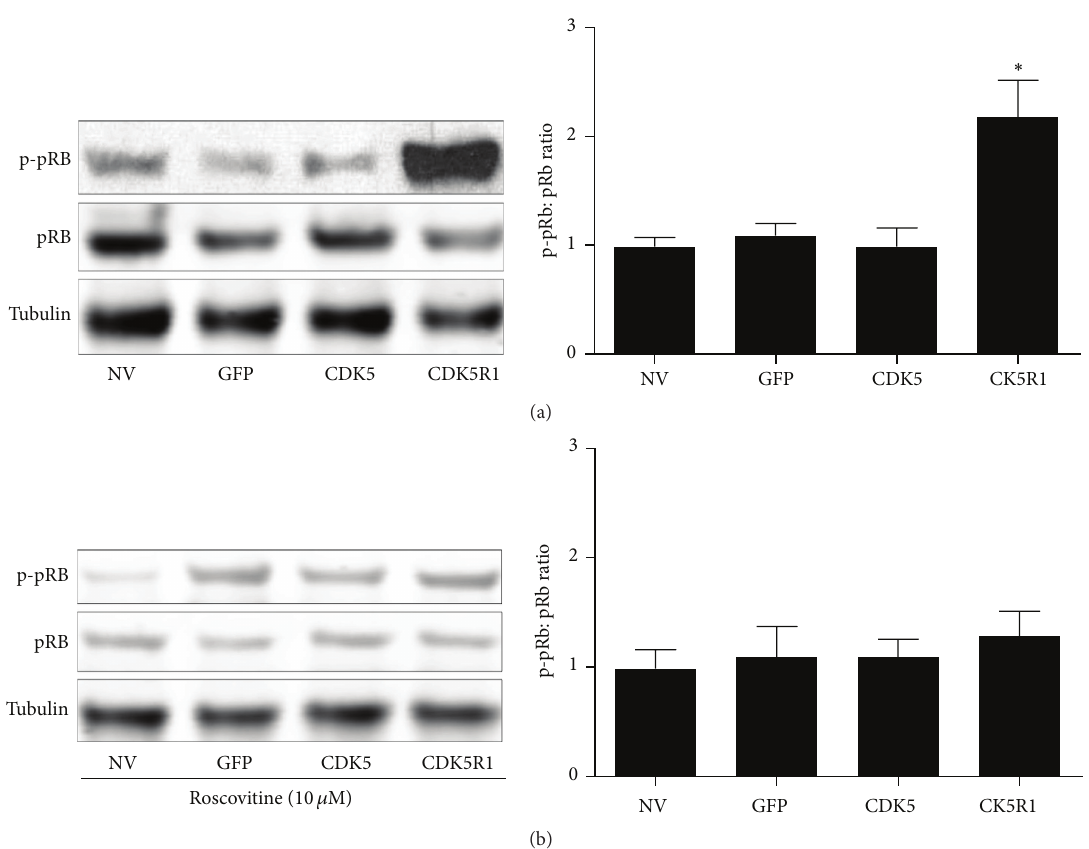
Figure 8: Overexpression of Cdk5r1 results in increased pRb phosphorylation. (a) Untransduced islets were compared to islets transduced with AdCMV-GFP, AdCMV-Cdk5, or AdCMV-Cdk5r1, and levels of phosphorylated pRb were measured. Representative western blot from four independent experiments. (b) Untreated islets and islets transduced with AdCMV-GFP, AdCMV-Cdk5, or AdCMV-Cdk5r1 were treated with 10 𝜇 M roscovitine and levels of phosphorylated pRb were measured. Representative western blots and quantitation from three